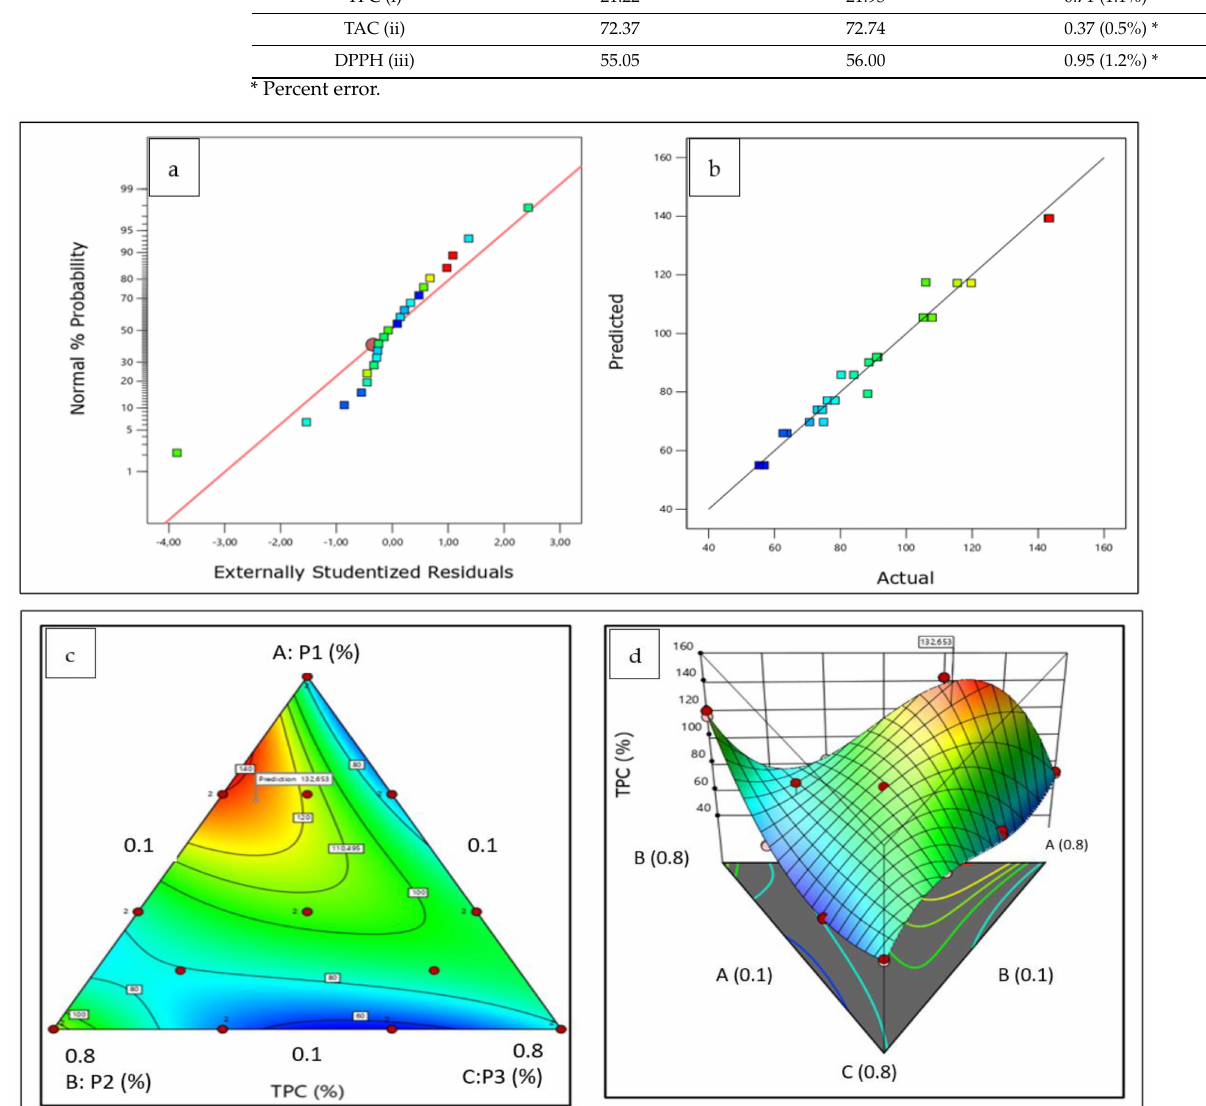
Figure 2. ( a ) Normal probability plot, ( b ) predicted versus actual plot, ( c ) contour plot, and ( d ) 3D surface plot of the effect of the three components on TPC